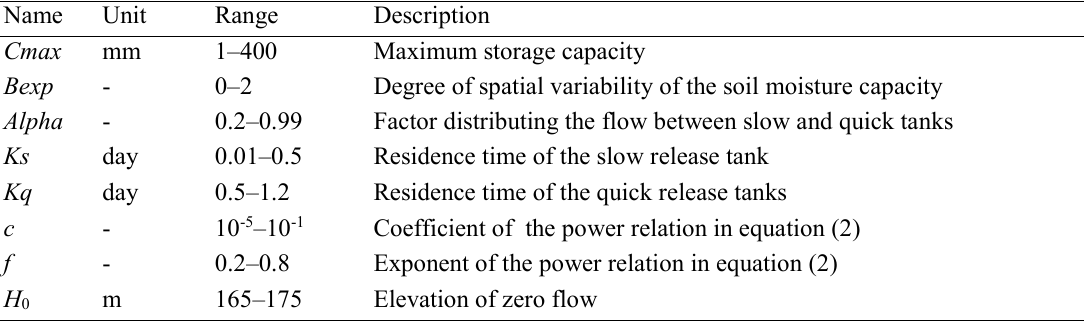
Fig. 1 The subbasins that were divided and the rainfall gauging stations. Table 1 Parameters of the model being calibrated against satellite observations and the prior parameter